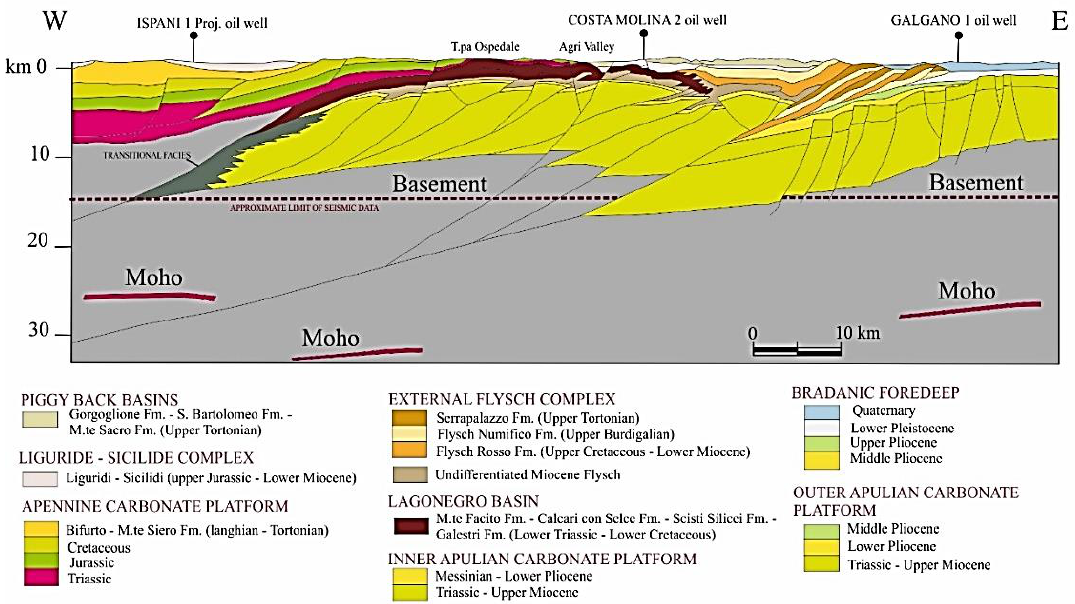
Figure 2. Geological section W–E crossing the Agri Valley from Menardi, Noguera, and Rea 2000, modified [30] .